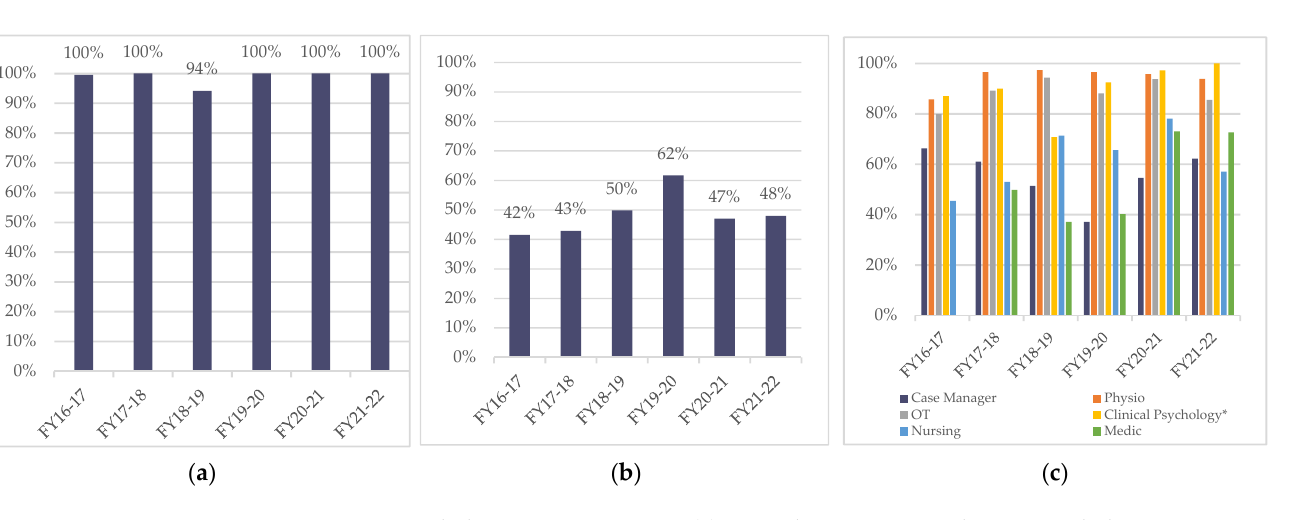
Figure 2. Annual percentage of inpatients who had a goal planning meeting in the last 4 weeks. 3.1.3. SMS-NAC within 2 Weeks of Mobilisation